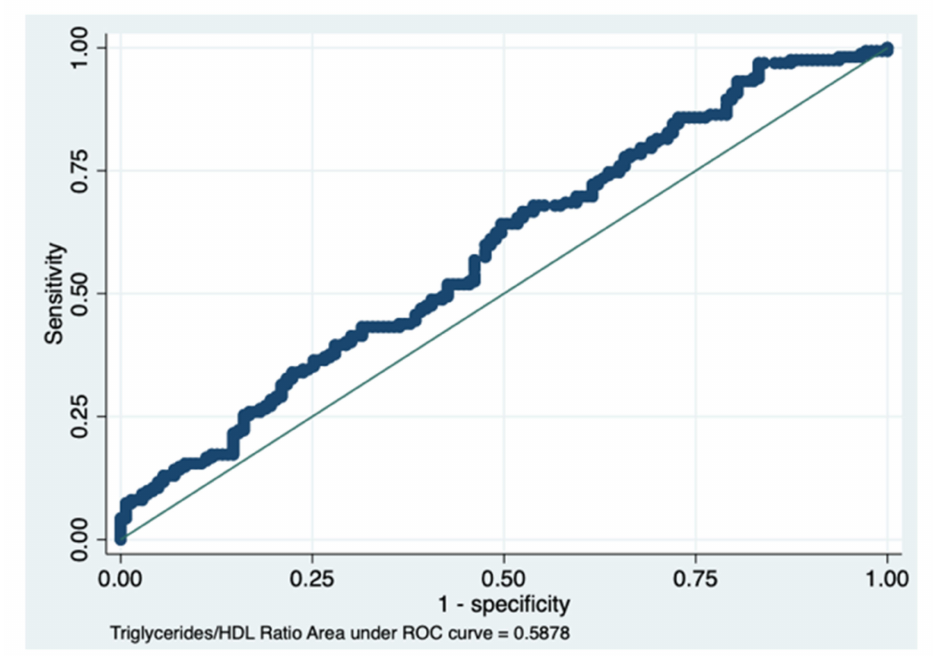
Figure 3. The area under the ROC curve of the triglycerides/HDL ratio. Details are presented in Table 4.